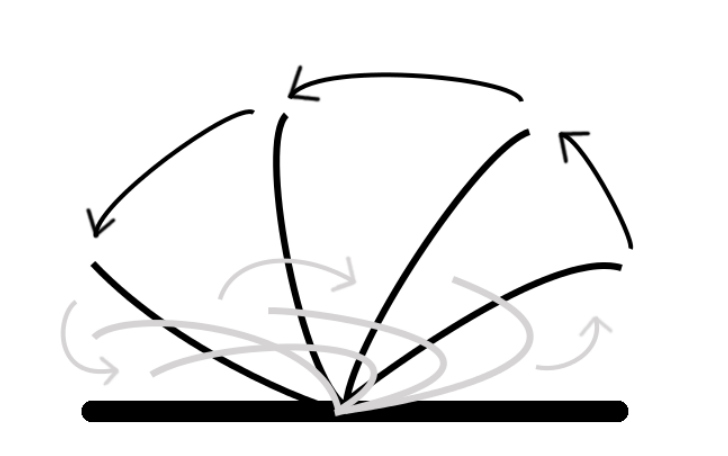
Figure 8. A typical ciliary beat cycle showing the power stroke in black and the recovery stroke in grey.